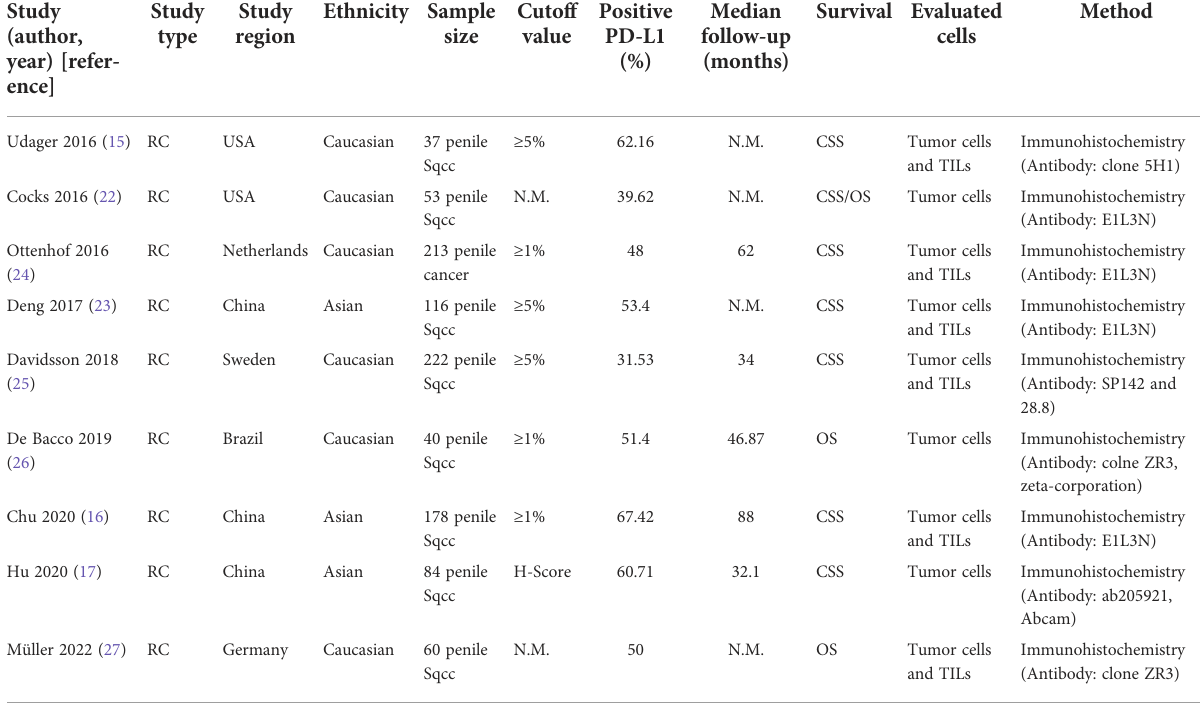
TABLE 1 Characteristics of included